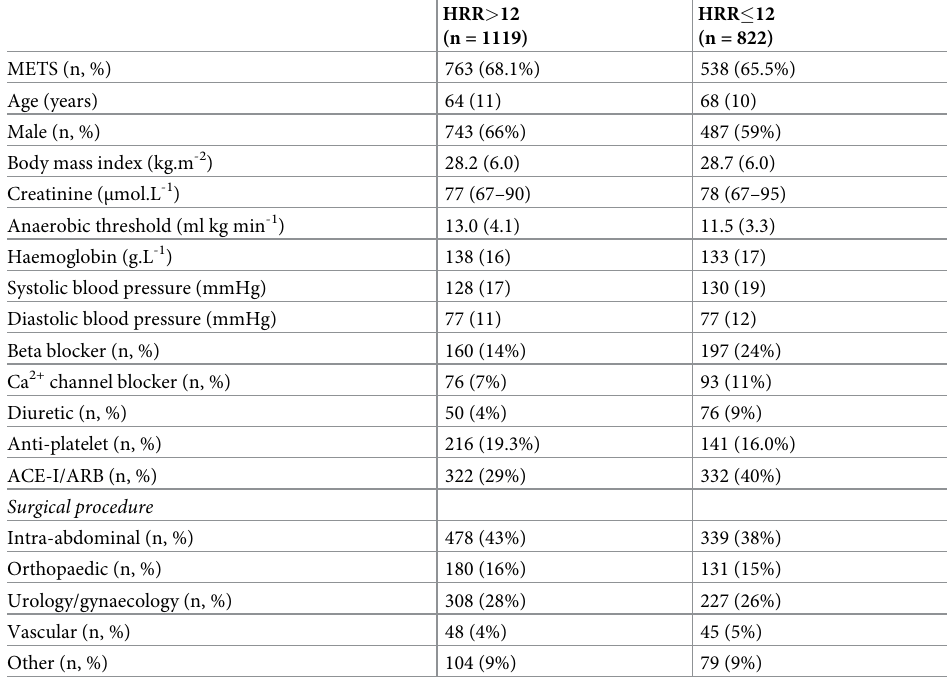
Table 1. Patient